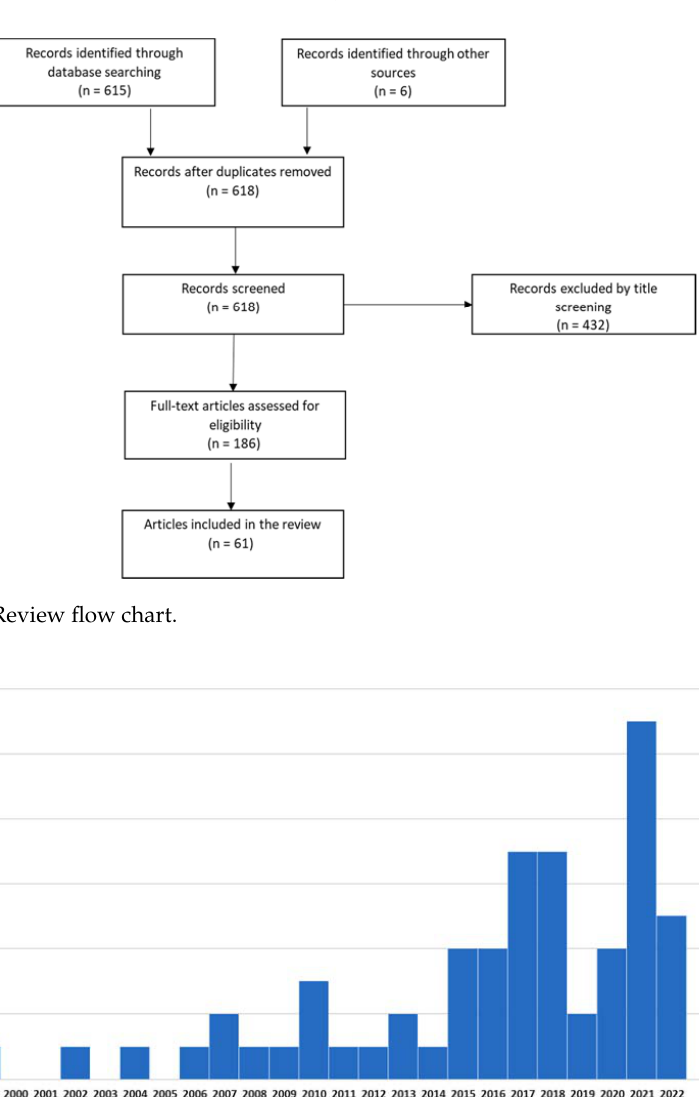
Figure 2. Evolution of the number of related articles with years.